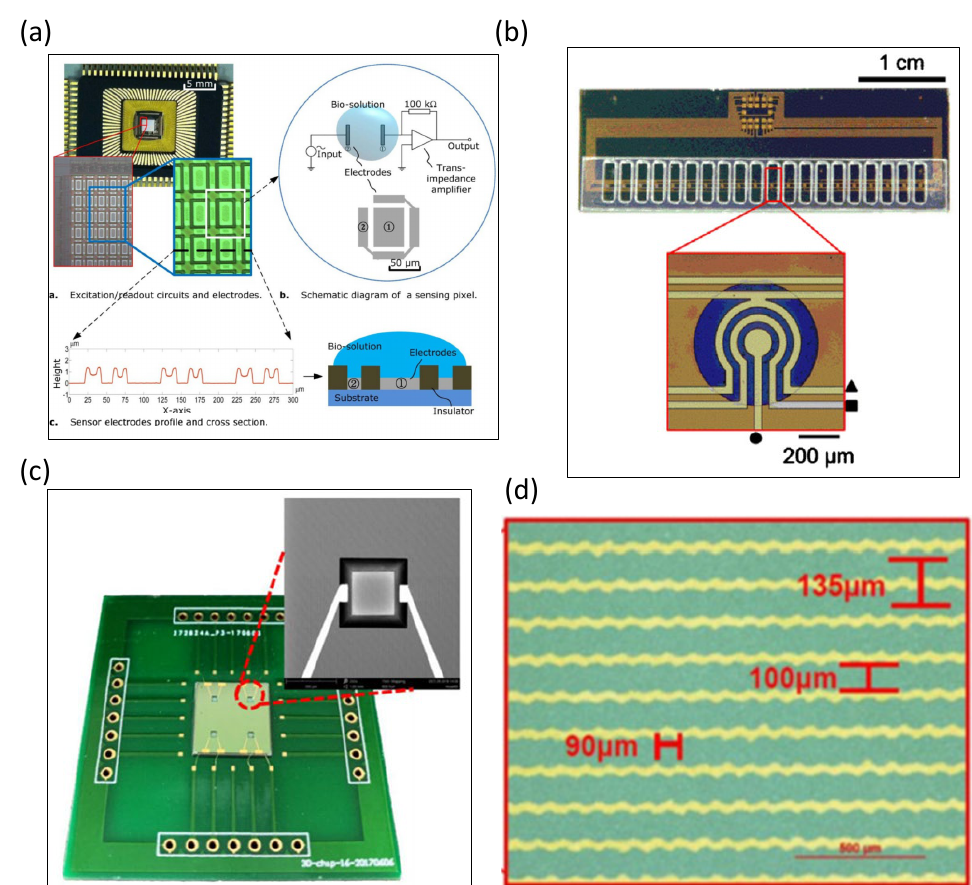
Figure 1. The silicon-based impedance biosensors. ( a ) A low-cost 0.35 mm CMOS technology by TSMC (Taiwan) was used to fabricate the micro-array chip that sensed DNA characterization. Reproduced with permission from [27]. Copyright Scientific Reports 2013. ( b ) Integrated surface plasmon resonance and electrochemical impedance spectroscopy in a microfluidic chip [30]. Reproduced with permission from [30]. Copyright Sensors and Actuators B: Chemical 2017. ( c ) Silicon substrates were microfabricated to create microgrooves. Reproduced with permission from [32]. Copyright Mi-